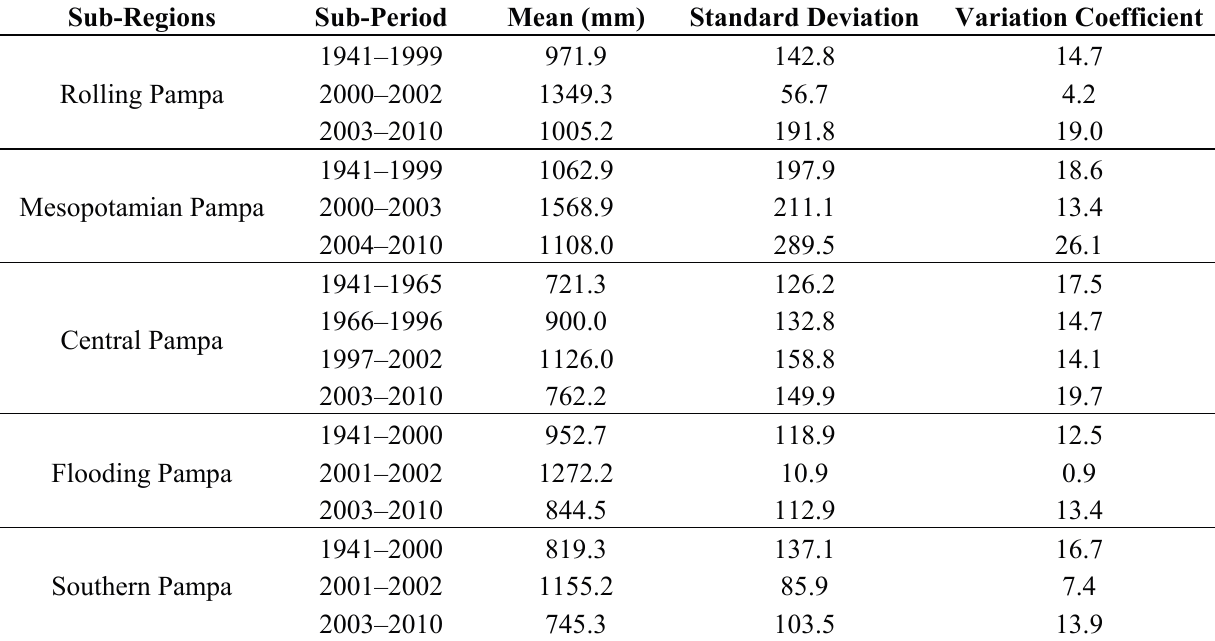
Table 3. Segmentation of the annual precipitation series for the sub-regions of the